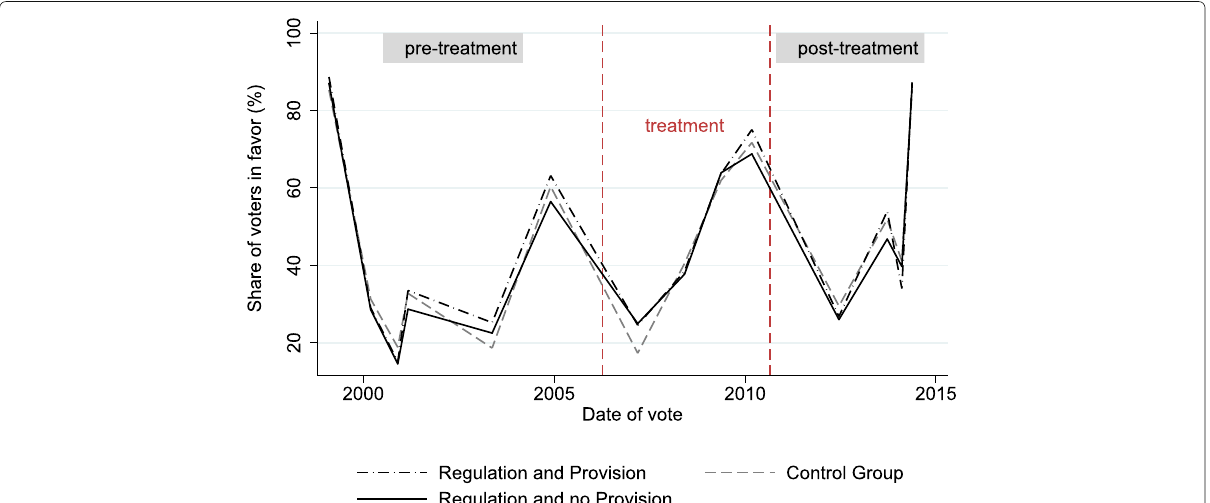
Fig. 8 Vote outcomes of 14 bills on healthcare-related topics in the municipalities with no regulation (mun. in the control cantons), municipalities with regulation but no provision, and municipalities with regulation and provision. The results displayed show population weighted means in vote outcomes for each of the three